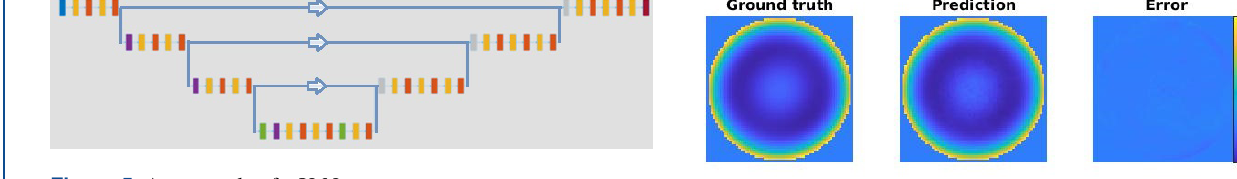
Figure 5. An example of a U-Net structure.